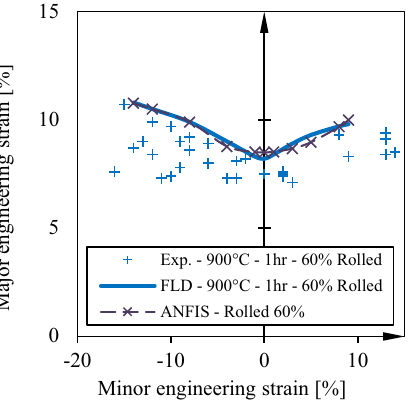
Figure 12. Comparison of experimental and simulation forming limits for St14 in different annealing